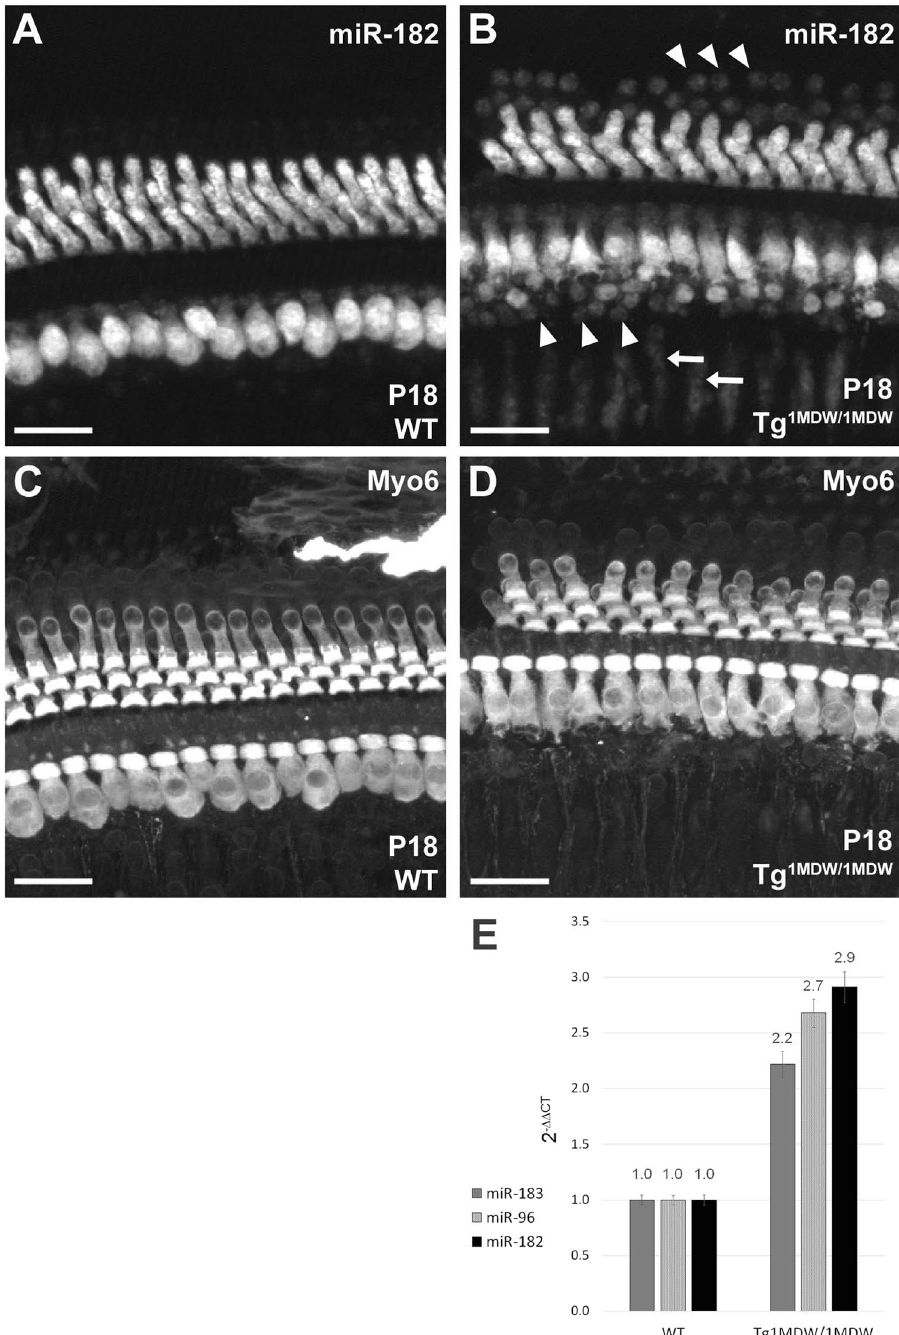
Figure 1. Supporting cell (SC) expression of miR-182 in Tg 1MDW/1MDW mice at P18. ( A – D ) Dual ISH/IHC fluorescence imaging of whole mount organ of Corti (OC) from WT ( A , C ) and Tg 1MDW/1MDW ( B , D ) P18 littermates. Cy5 fluorescence of tyramide enhanced miR-182 ISH labeling shows nuclear/cytoplasmic staining in hair cells (HCs A , B ) and definitive Tg 1MDW/1MDW OC SC nuclear staining, including Deiters’, inner pillar, outer pillar, inner phalangeal and inner border cells (B, arrowheads). SC labeling with miR-182 was found in spiral limbus cells and myelinated Schwann cells of spiral ganglion neurons ( B , arrows). Alexa 546 immunofluorescence of MYO6 positive HCs ( C , D ). ( E ) Quantitative increase in miR-183 cluster in P18 Tg 1MDW/1MDW total cochlear RNA by RT-PCR. Using ABI Taqman assays, quantitative RT-PCR was performed in Tg 1MDW/1MDW versus WT littermates (n = 3). The miR-183, miR-96 and miR-182 levels were normalized to Sno135. The results quantitate statistically significant ( Δ CT values, 2 sample t-test, P < 0.001) increases in miR-182 (2.9 fold), miR-96 (2.7 fold) and miR-183 (2.2 fold) in Tg 1MDW/1MDW cochlea at P18. These data are consistent with a transgenic misexpression of these neurosensory miRNAs via the core human GFAP promoter and validate microarray data. Scale bar: 20 μ M ( A – D